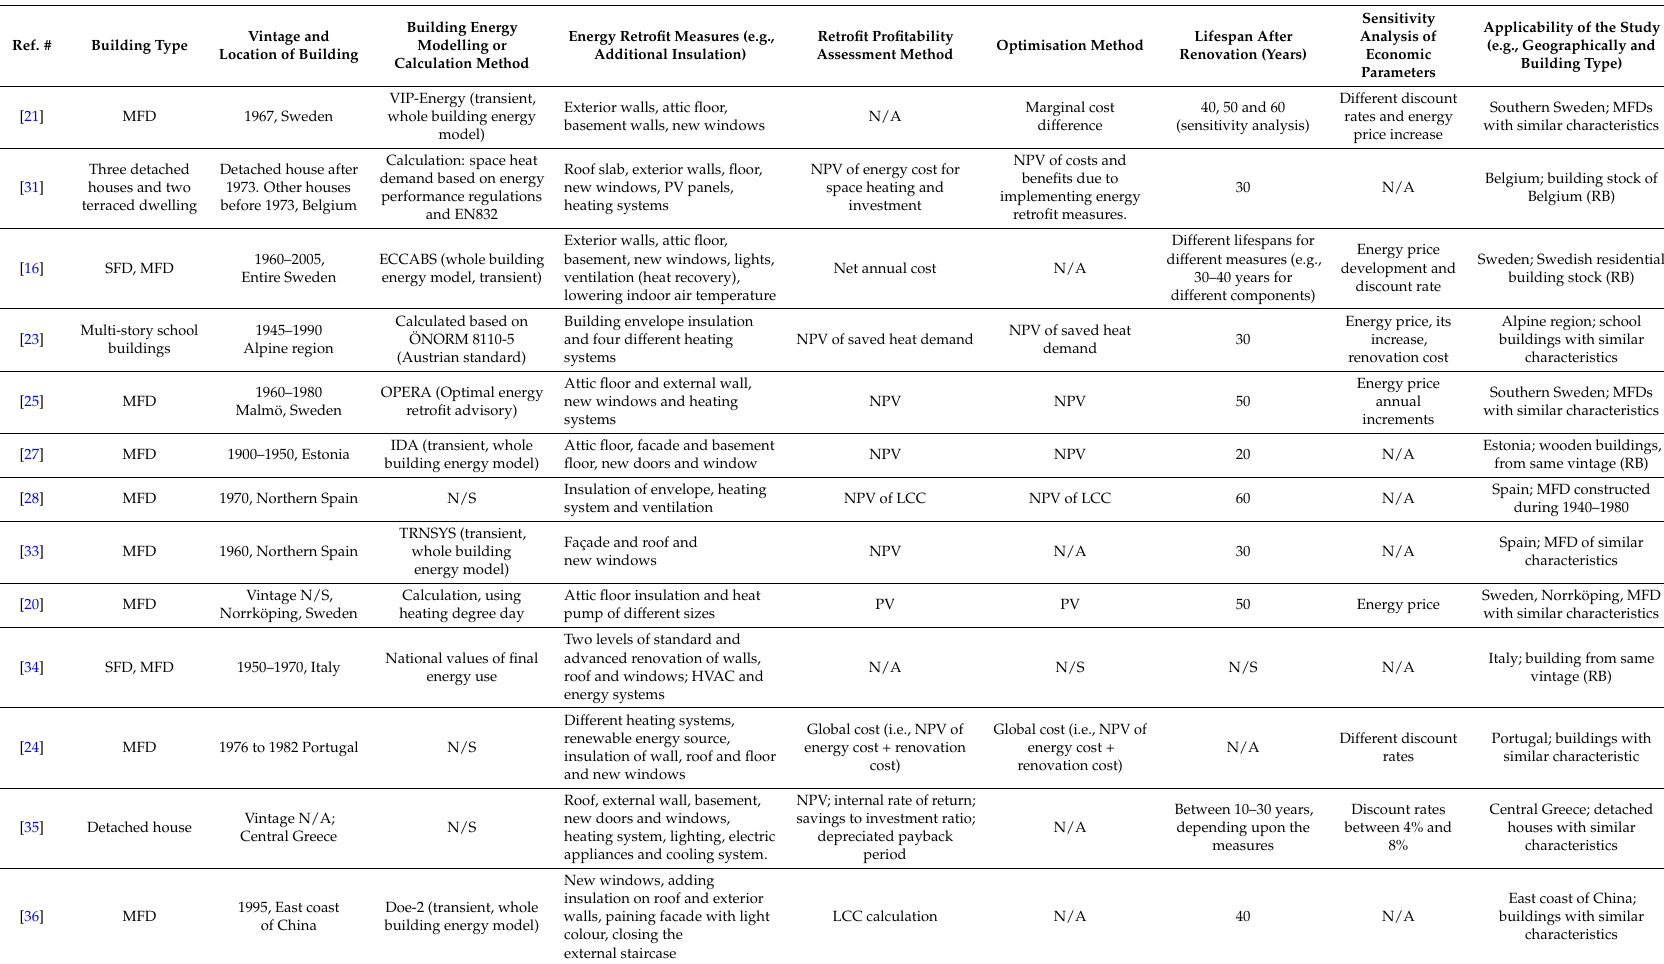
Table 1. A summary of existing literature works with the subject of cost-optimization and cost-effectiveness of building renovation.